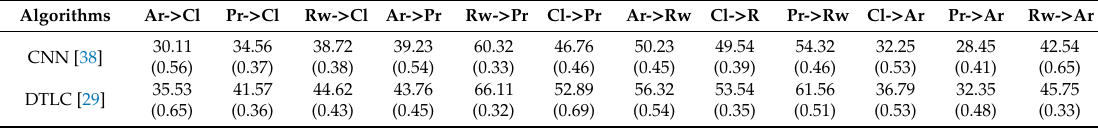
Table 4. Average accuracy rate (%) with absolute value of standard variation on O ffi ce + Home dataset.